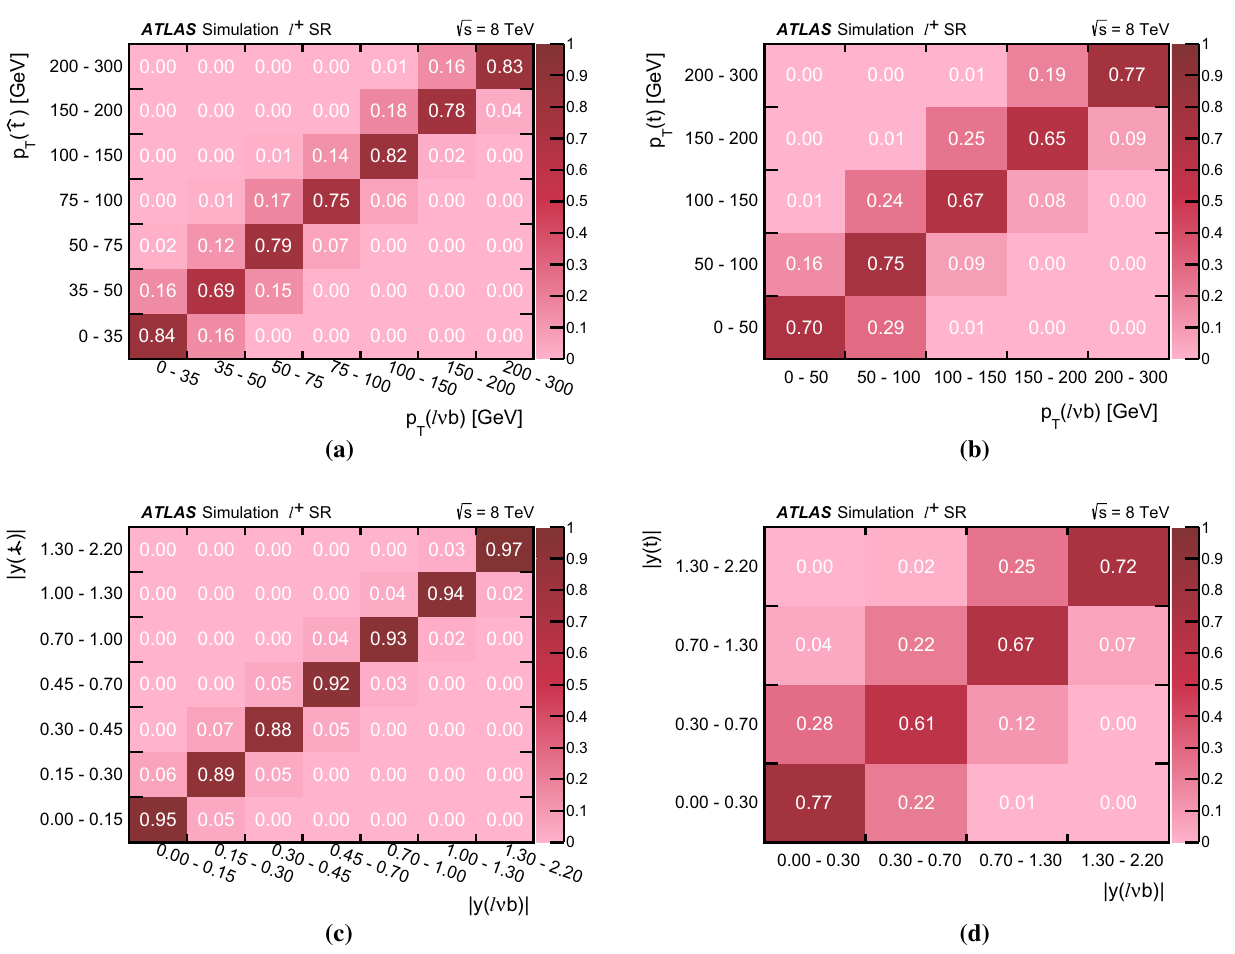
Fig. 16 Migration matrices for a p T ( ˆ t ) , b p T ( t ) , c | y ( ˆ t ) | and d | y ( t ) | . a , c Particle level, while b and d are for parton level. The pseudo top quark or parton-level quark is shown on the y -axis and the reconstructed variable is shown on the x -axis